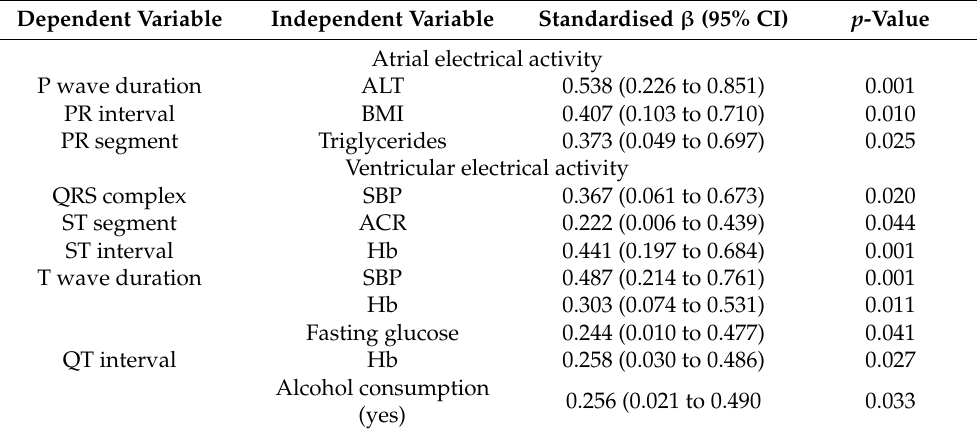
Table 5. Significant associations between cardiometabolic parameters and atrial/ventricular electrical activity in the HIV+/ART+ study